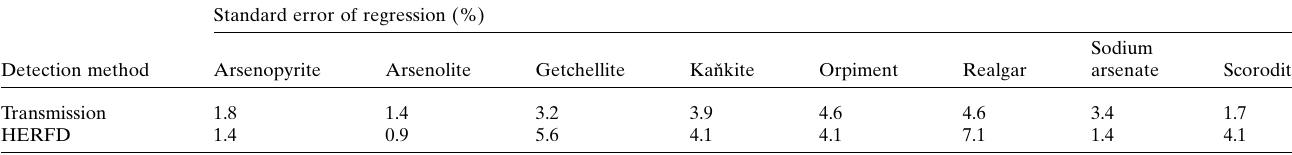
Table 2 Standard error of regression for LCF results for each reference compound in all mixture combinations in both transmission-detected XANES and HERFD-XANES.